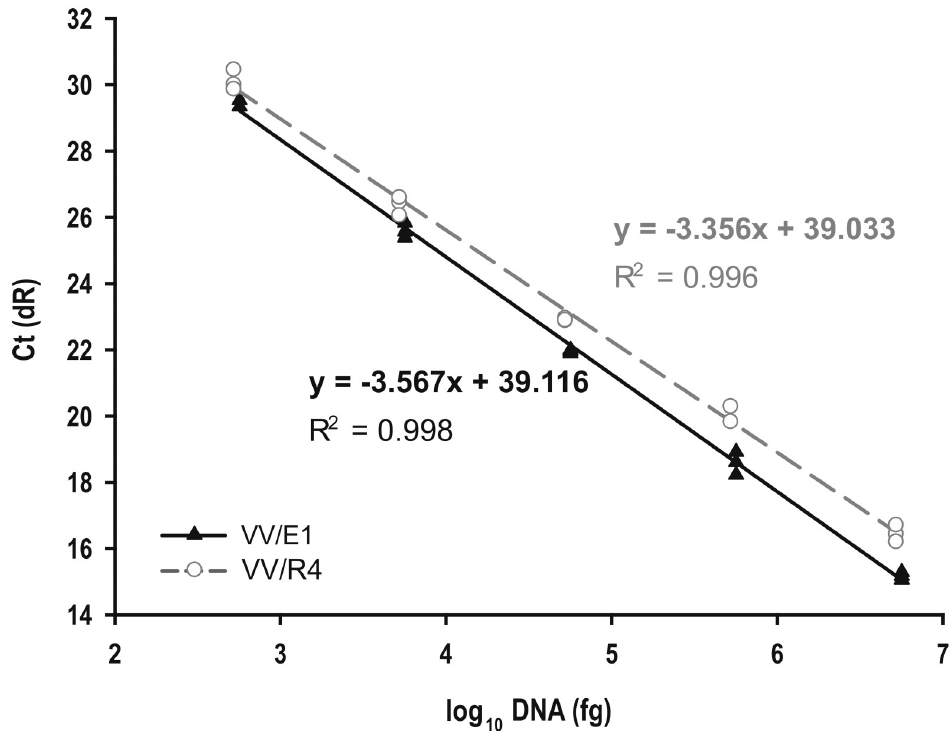
Fig 4. qPCR standard curves. Representative amplification curves obtained by plotting the mean Ct values with respect to the logarithm of genomic DNA quantity from Streptomyces sp. VV/E1 (black line) and Streptomyces sp. VV/ R4 (grey line). Standard curves were generated with 10-fold serial dilutions of genomic DNA concentrations from 5.65 x 10 6 fg to 56.5 fg (VV/E1 strain) or 5.2 x 10 6 fg to 52.0 fg (VV/R4 strain) by SYBR green qPCR reactions.